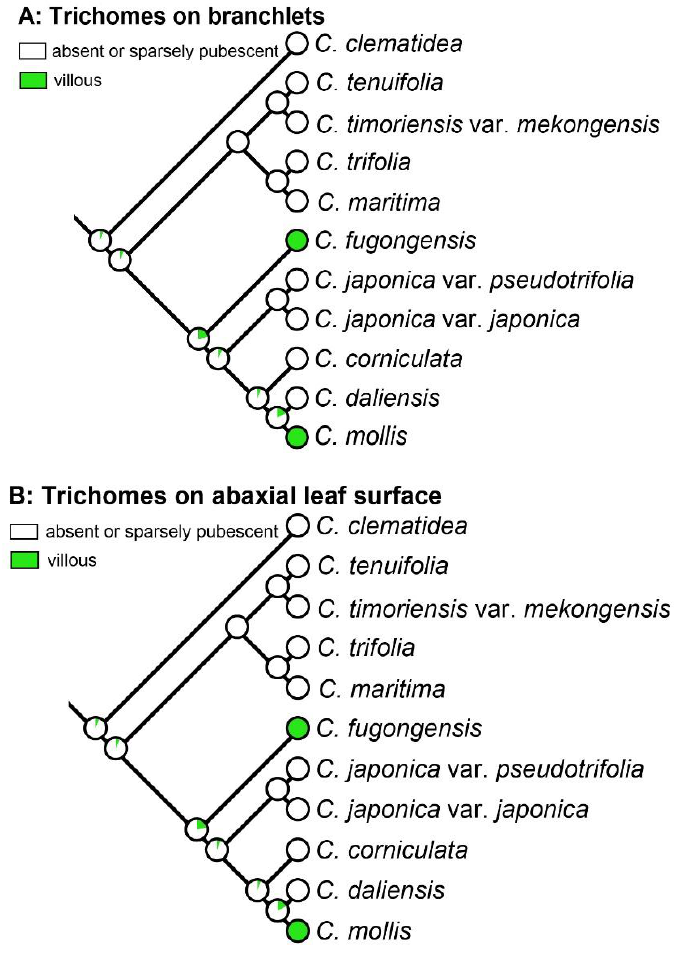
Figure 3. PCA of the selected taxa of Causonis based on trichomes on branchlets, abaxial, and adaxial leaf surfaces.